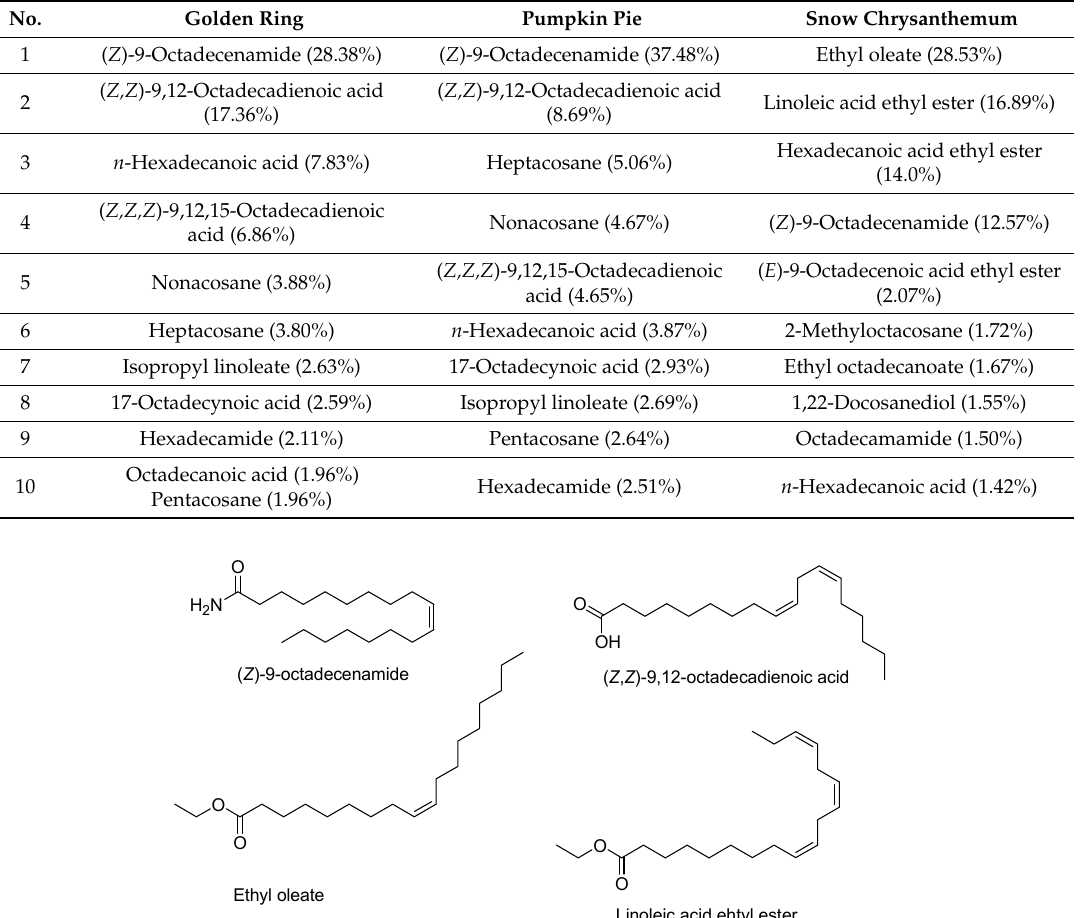
Figure 2. Relative content (%) of volatile compounds in ( a ) “golden ring”; ( b ) “pumpkin pie”; ( c ) “snow chrysanthemum”. Table 2. Top ten volatile compounds in “golden ring”, “pumpkin pie” and “snow chrysanthemum”.